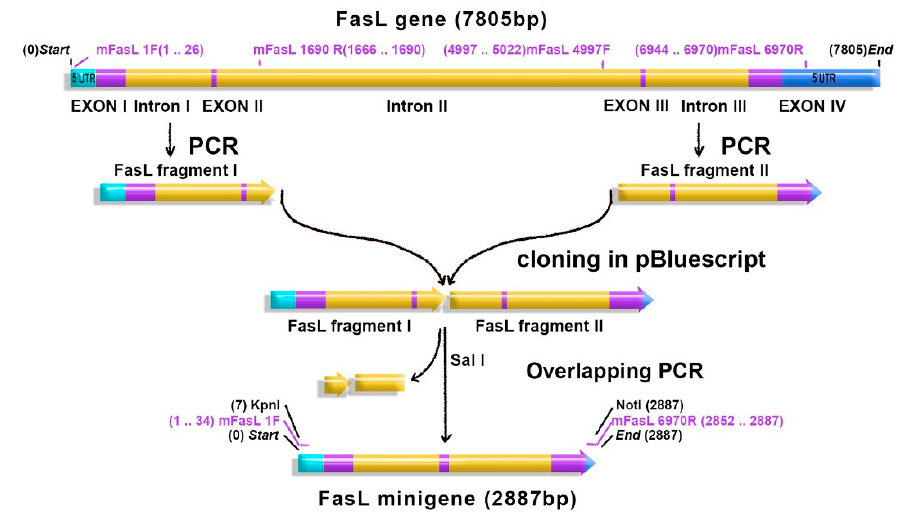
Figure 1. Fas ligand (FasL) minigene construction: the FasL murine gene (7805 bp) consists of four exons (purple) and three introns (yellow). Untranslated regions (UTR—blue) flank the introns and the exons. FasL 5 ′ fragment (FasL fragment I) and FasL 3 ′ fragment (FasL fragment II) were amplified by PCR and successively cloned in pBluecript. The remaining fragments of the intron II were removed by overlapping PCR, and exons II and III (purple) were linked in frame. The obtained minigene (2887 bp) was cloned in the pAdTrack-CMV adenoviral vector in the KpnI/NotI restriction site.